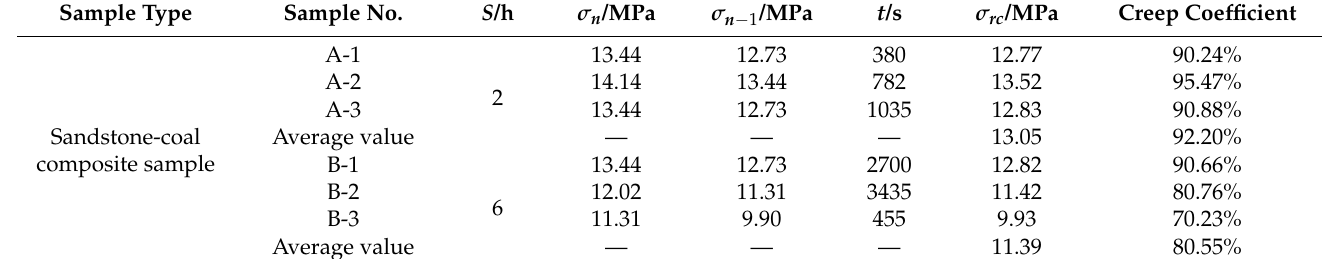
Table 2. σ n , σ n − 1 , t and creep coefficients of sandstone-coal composite samples.